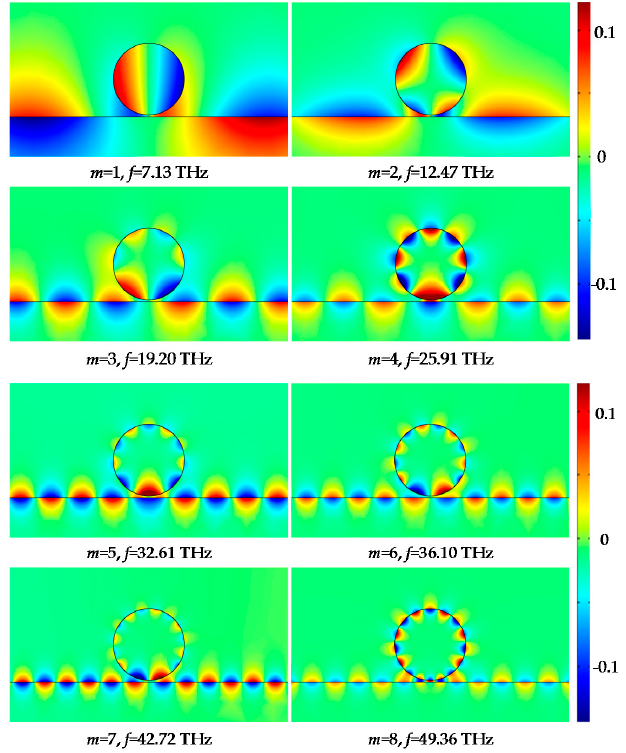
Figure 4. Simulation results of magnetic-field (H z ) distribution at the resonant state of mode 1–8 for the GNW.